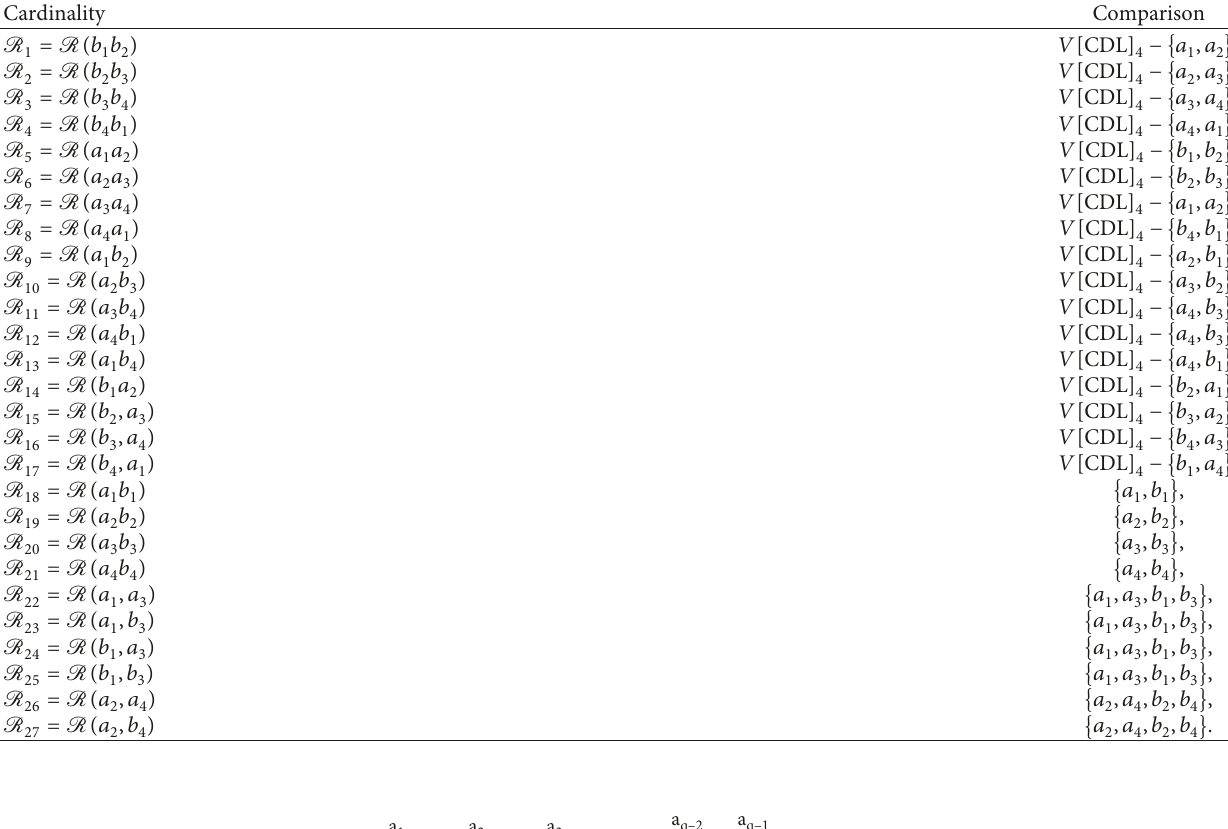
Table 4: Cardinality of each RN set.